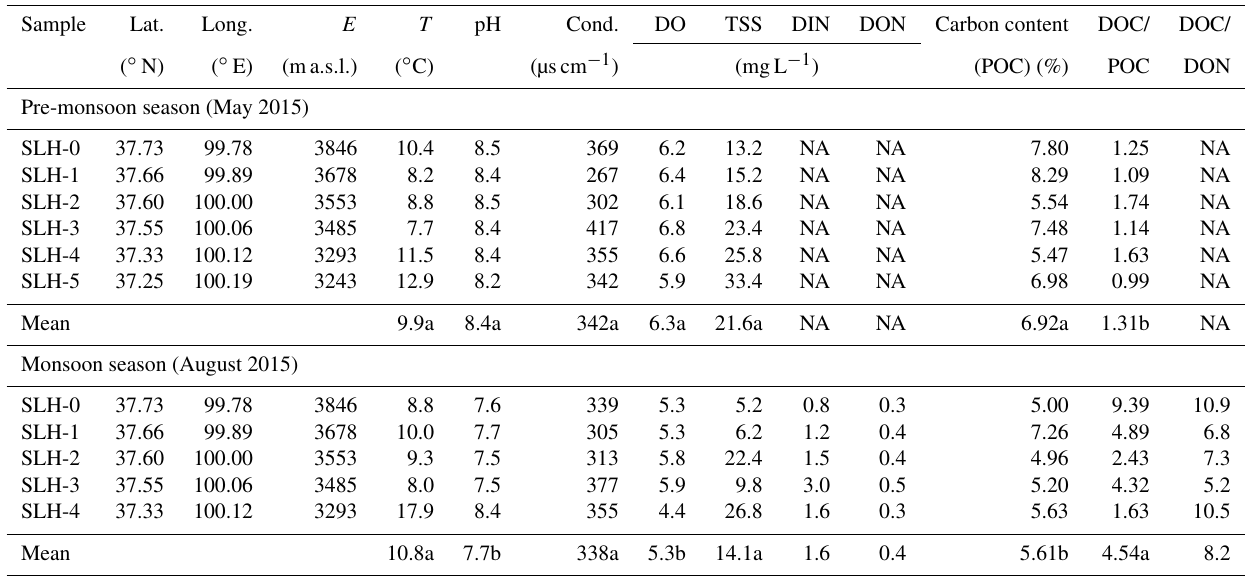
Table 1. River water properties along the Shaliu River. Sample Lat. Long.